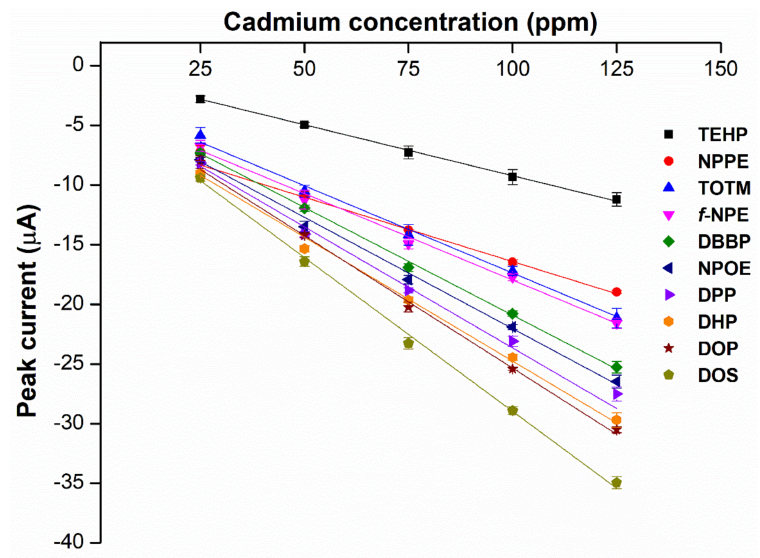
Figure 3. Relationship between peak current of the different types of primary plasticizer sensors and the different concentrations of cadmium(II), ( n = 5). Table 1. Chemical properties of plasticizers used for the construction of cadmium-selective membrane; E = dielectric